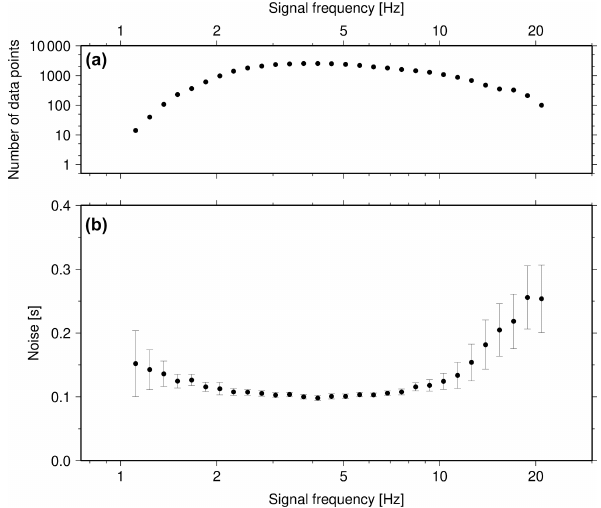
Figure 7. The hierarchical McMC method allows for the inversion of data noise. We inverted for the frequency-dependent data noise: (b) shows the recovered data noise at every signal frequency anal- ysed. Panel (a) shows the number of data points (travel times/group velocities). In the frequency range between 2 and 10Hz, corre- sponding to at least several hundred data points per frequency, the noise level is low: i.e. this part of the data contributes significantly to the derivation of the final